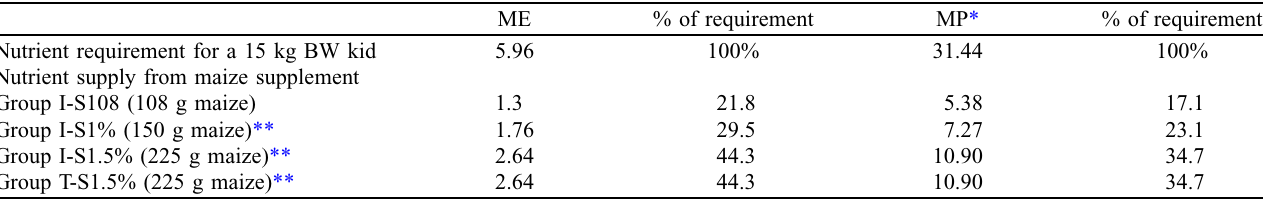
Table 2. Maintenance requirements of metabolizable energy (ME; MJ/d) and metabolizable protein (MP; g/d) for 15 kg BW kids (50 g/d of BW gain, walking 10 km/d), and nutrient supply from supplement (ground maize grain fresh basis) in the respective experimental groups (including the % of the requirement covered with the supplement) (as per AFRC,